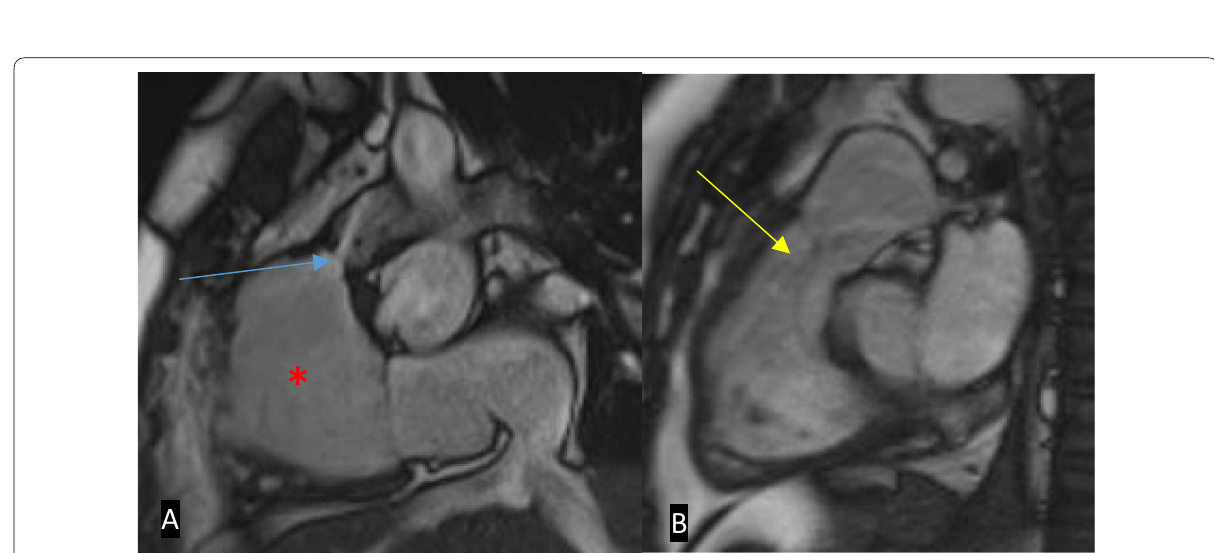
Fig. 18 MRI SSFP cine images in two different patients post-TOF repair taken in the RVOT plane. A There is RVOT residual obstruction with a stenotic jet (blue arrow) with RV dilatation (red asterisk). B A jet of pulmonary regurgitation can be seen (yellow arrow). RVOT: right ventricular outflow tract; RV: right